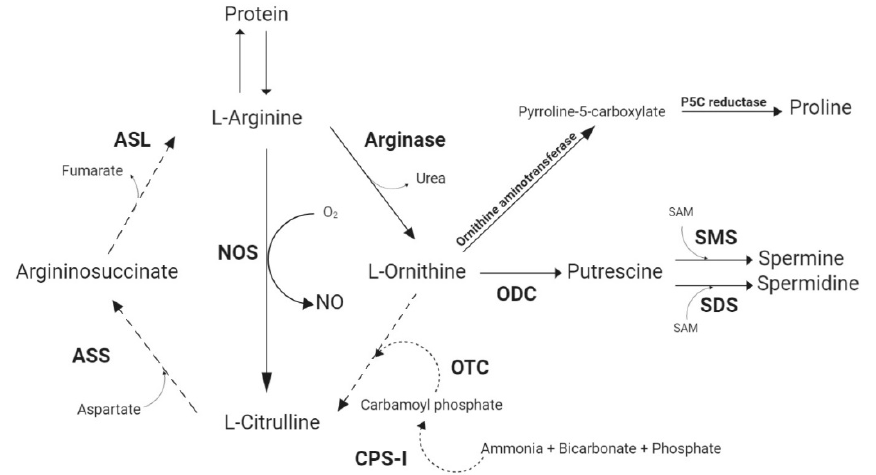
Figure 1. Arginine metabolism. Dotted lines represent pathways that are inactive or less active in birds than in mammals. CPS-I—carbamoyl phosphate synthase I; OTC—ornithine transcarbamylase; ASS—argininosuccinate synthetase; ASL—argininosuccinate lyase; NOS—nitric oxide synthase; ODC—ornithine decarboxylase; SMS—spermine synthase; SDS—spermidine synthase.